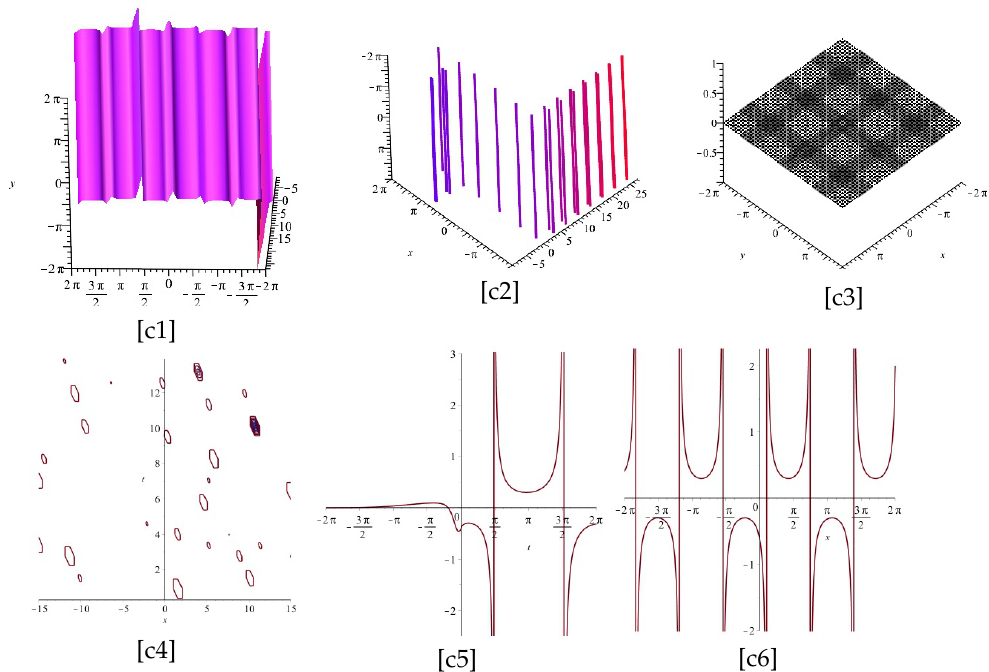
Figure 3. The plots of Equation (30), for λη > 0 and α = 0.75. Now, [c1] and [c3] are the imaginary and real parts of Equation (30), and [c2], [c4], [c5], and [c6] display the z -axis orientation, the contour plot, the 2d for x = 2, and the 2d for t = 2, of the imaginary part of [c1], respectively.